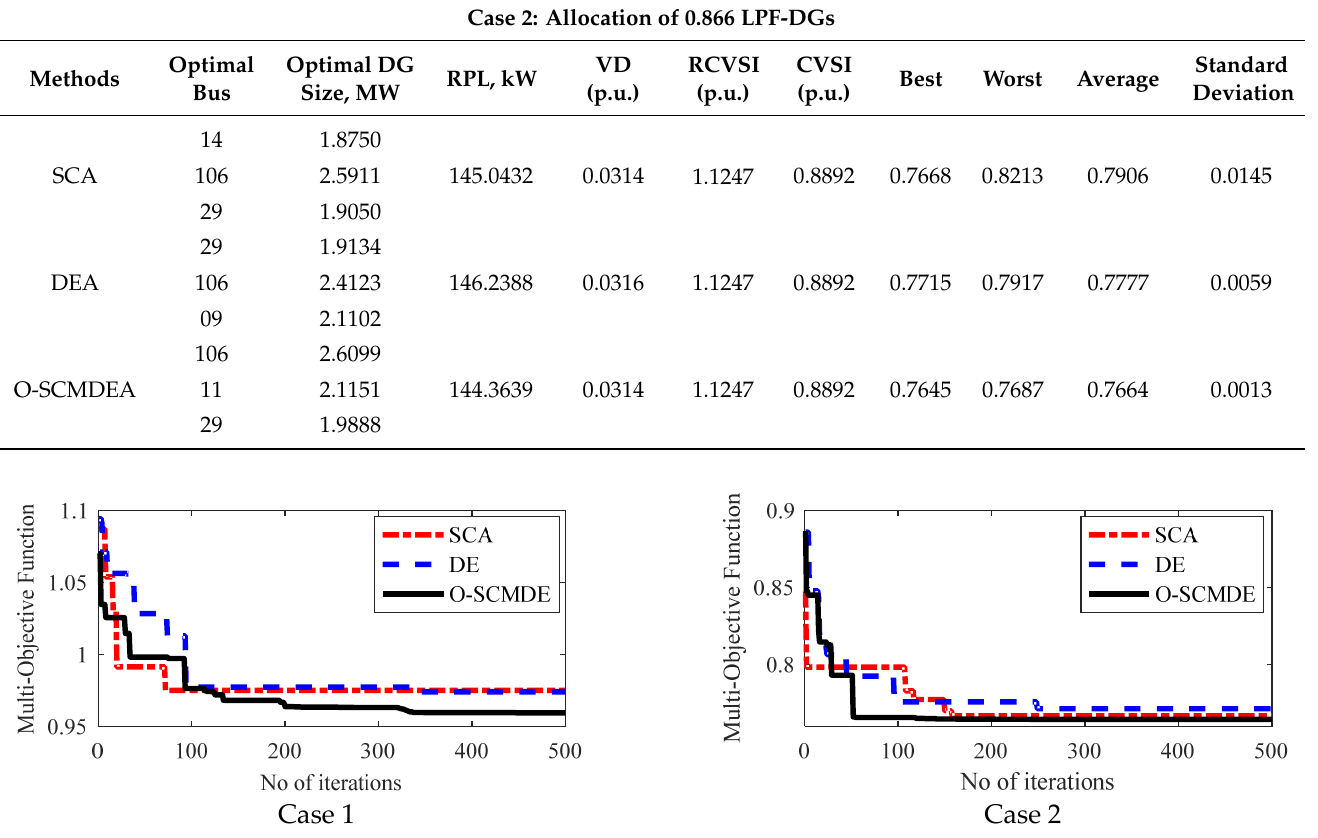
Figure 17. Comparison of the convergence characteristics of the SCA, DEA and O-SCMDEA for both cases of scenario IV of the 136 bus system.